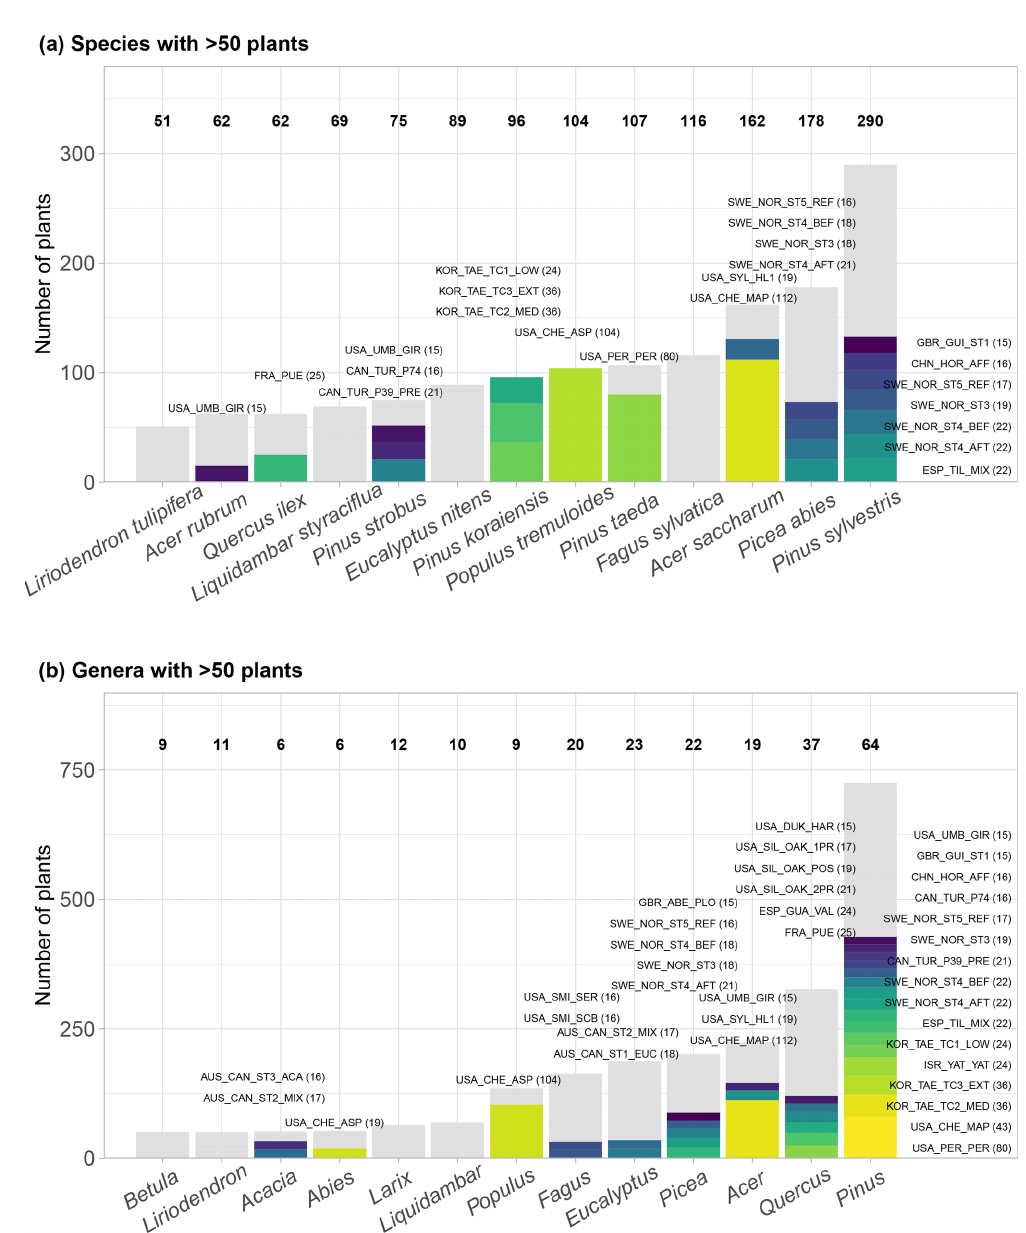
Figure 3. Taxonomic distribution of genera and species in SAPFLUXNET, showing (a) species and (b) genera with > 50 plants in the database. Total bar height depicts number of plants per species (a) or genus (b) . Numbers on top of each bar show the number of datasets where each species (a) or genus (b) is present. Colours other than grey highlight datasets with 15 or more plants of a given species (a) or genus (b) . Bar height for a given colour is proportional to the number of plants in the corresponding dataset, which is also shown in parentheses next to the dataset